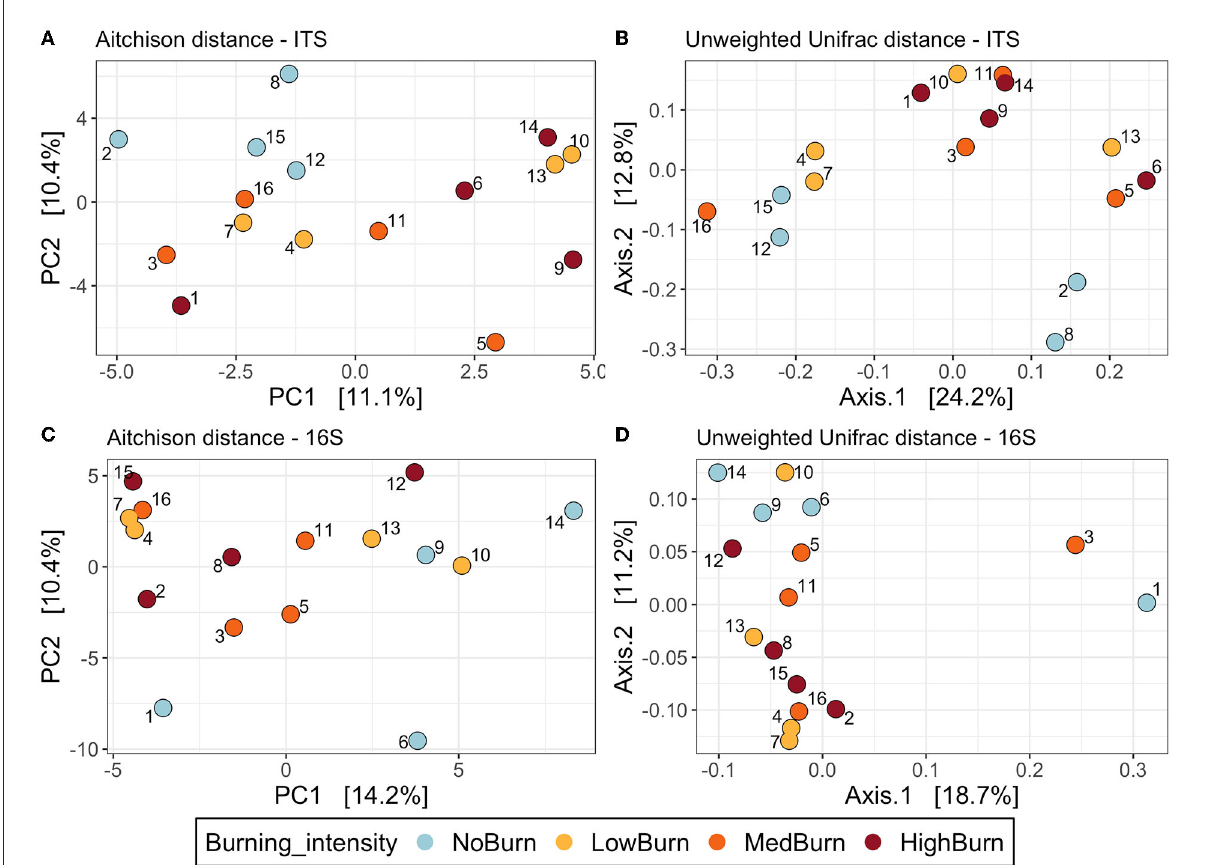
FIGURE7 Beta diversity ordinations of the fungal and bacterial communities. (A,B) represent principal component analysis (PCA) and principal coordinate analysis (PCoA) ordinations of the fungal community using the Aitchison distance (Euclidean distance on centered-log ration transformed abundances and the unweighted Unifrac distance based on phylogeny dissimilarity, respectively. (C,D) represent the same ordinations but of the bacterial